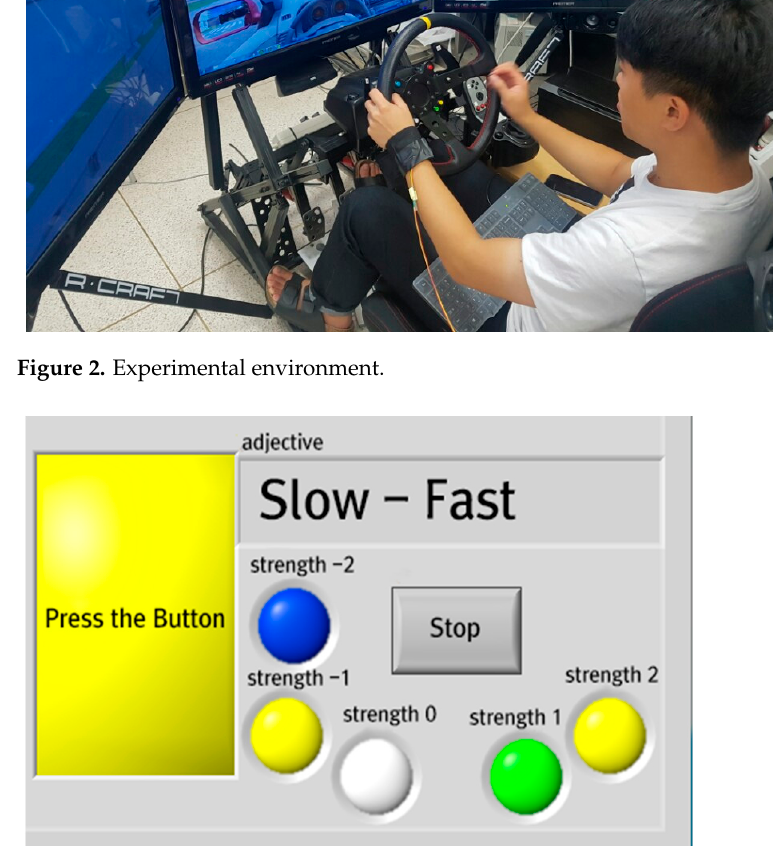
Figure 3. Interface for KW measurement.